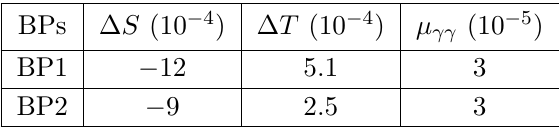
Table 3 . Estimate of electroweak precision parameters and (cid:22) (cid:13)(cid:13) for the two benchmark points as chosen in table